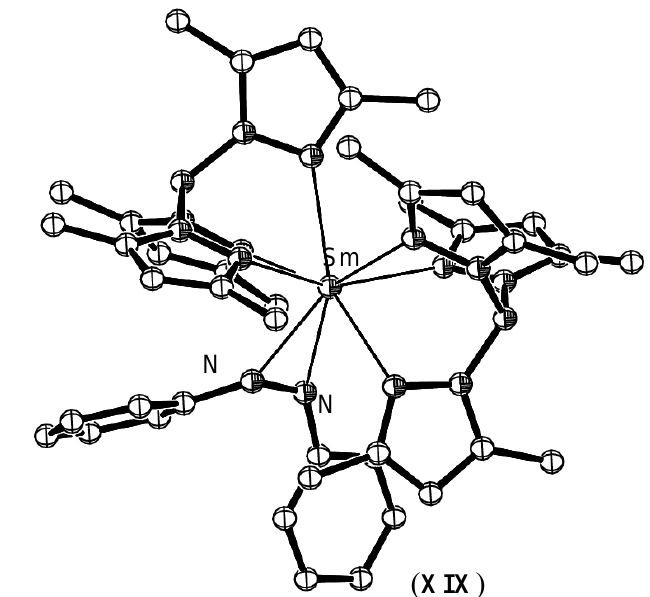
Figure 8. Molecular structure of [Sm{HB-(3,5-Me generated from CCDC obtained coordinates. Atoms of arbitrary size. H atoms are omitted for